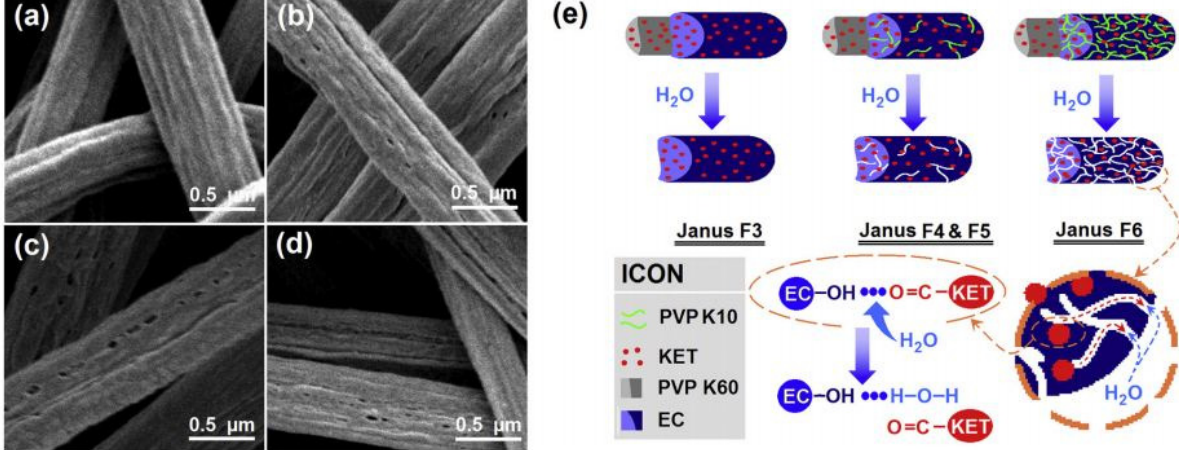
Figure 19. ( a ) Experimental apparatus of side-by-side electrospinning process; ( b ) photograph of typical side-by-side electrospinning process; ( c ) Janus Taylor cone formed with Teflon-coated spinneret; ( d ) mat of fibers produced using non-coated side-by-side spinneret; ( e ) separation of fluids when using non-coated side-by-side spinneret and ( f ) illustration of the influence of Teflon-coated spinneret: A separation of fluids arising from repulsive forces and B formation of the integrated Janus Taylor cone with the Teflon coating (reprinted from reference [174] with permission from Elsevier).